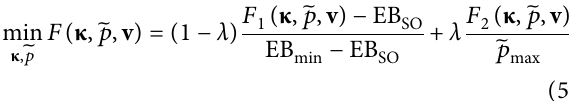
economic benefit at SO and deterministic UE statuses (i.e., TCS is not implemented and naturally no perception error on the travel cost exists), respectively. The main findings are presented as